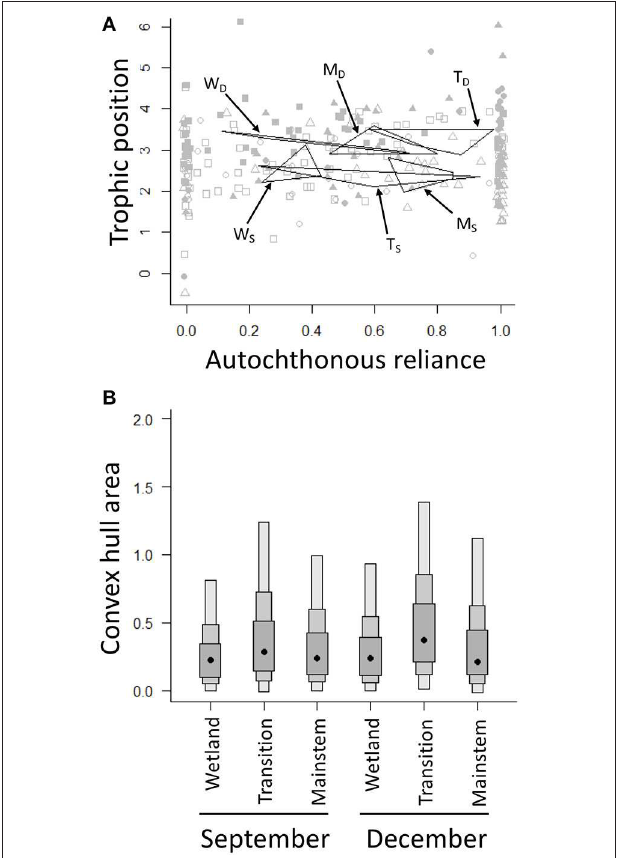
FIGURE 4 | (A) Convex hulls for the three regions of the GLM complex in September [open squares = wetland (W S ), open circles = transition (T S ), open triangles = mainstem (M S )] and December [filled squares = wetland (W D ), filled circles = transition (T D ), filled triangles = mainstem (M D )]. Convex hulls are based on the centers of each of the functional feeding groups that make up each community. (B) Density plots of the convex hull area are based on posterior estimates from Bayesian mixing models analyzed using the R package SIBER . Black dots depict group modes, and the shaded boxes represent the 50% (dark gray), 75% (gray), and 95% (light gray) confidence